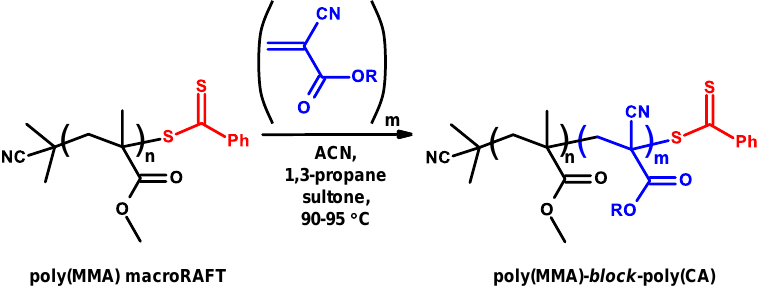
Scheme 16. RAFT polymerization of CAs using a macroRAFT (reversible addition-fragmentation chain transfer) agent.